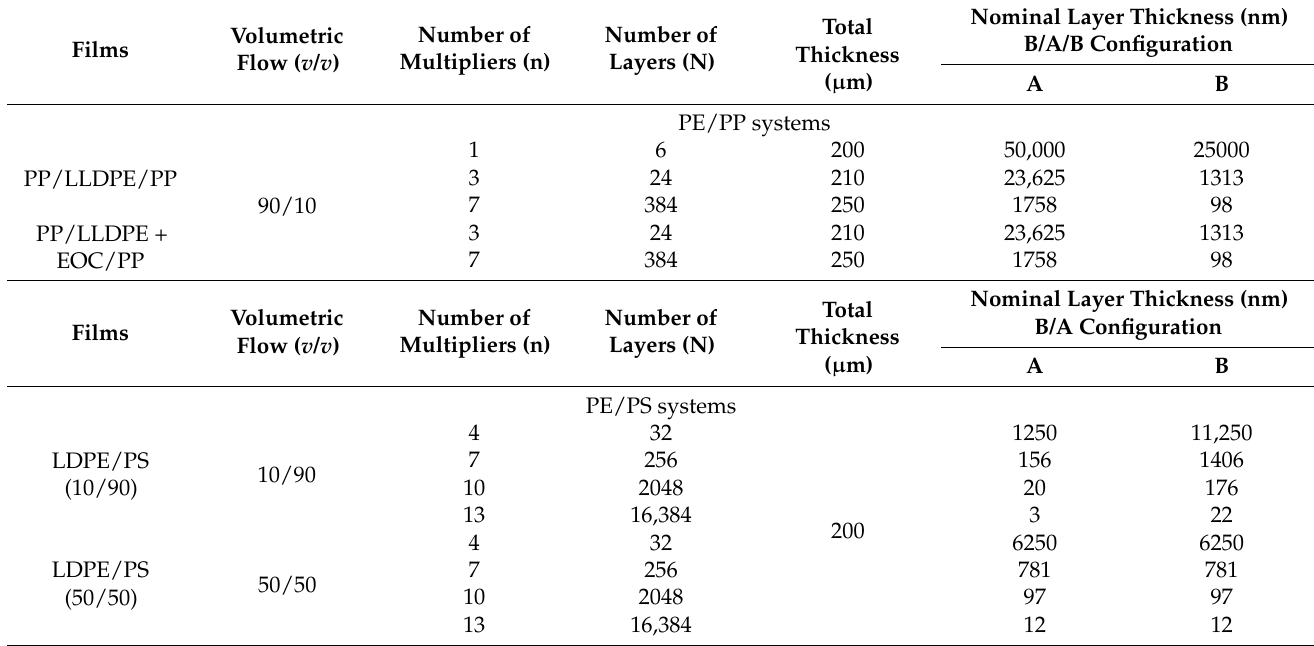
Table 2. Characteristics of the PE/PP and PE/PS multilayer films obtained by coextrusion.